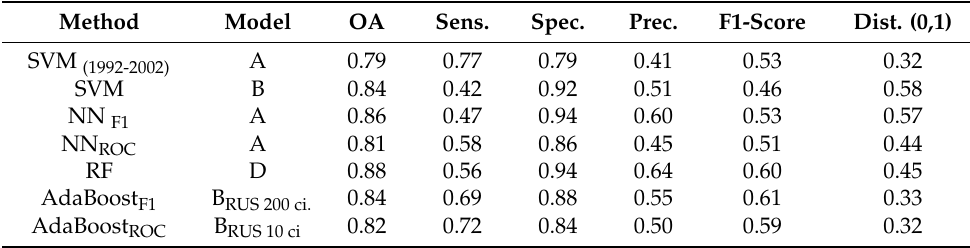
Table 9. Results of the best models for each machine learning method, as well as for the SVM model based on A developed by Gonzalez Vilas at al. [20]. Subscripts indicate the criterion for model selection in the case of discrepancy between the maximizing F1-score and minimizing distance to point (0,1) in the ROC curve. All the metrics are computed from the validation set. (OA: Overall accuracy; Sens.: sensitivity; Spec.: specificity; Prec.: precision; Dist. (0,1): distance to the point (0,1) in ROC